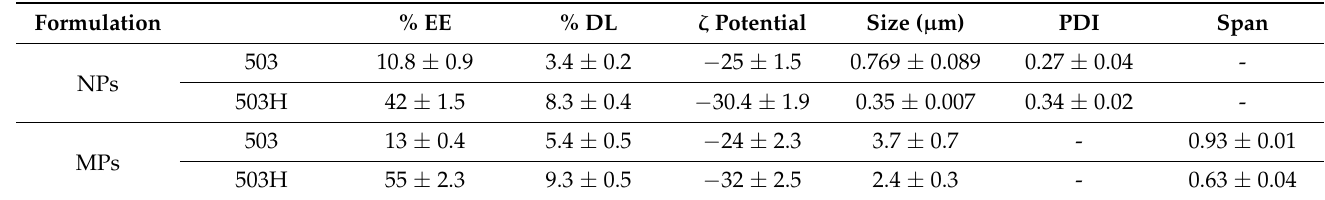
Table 2. Characteristics of nanoparticles (NPs) and microparticles (MPs) prepared from both PLGA types. EE = encapsulation efficiency; DL = drug loading; ζ = zeta potential; DI = polydispersity index. ( n = 3).